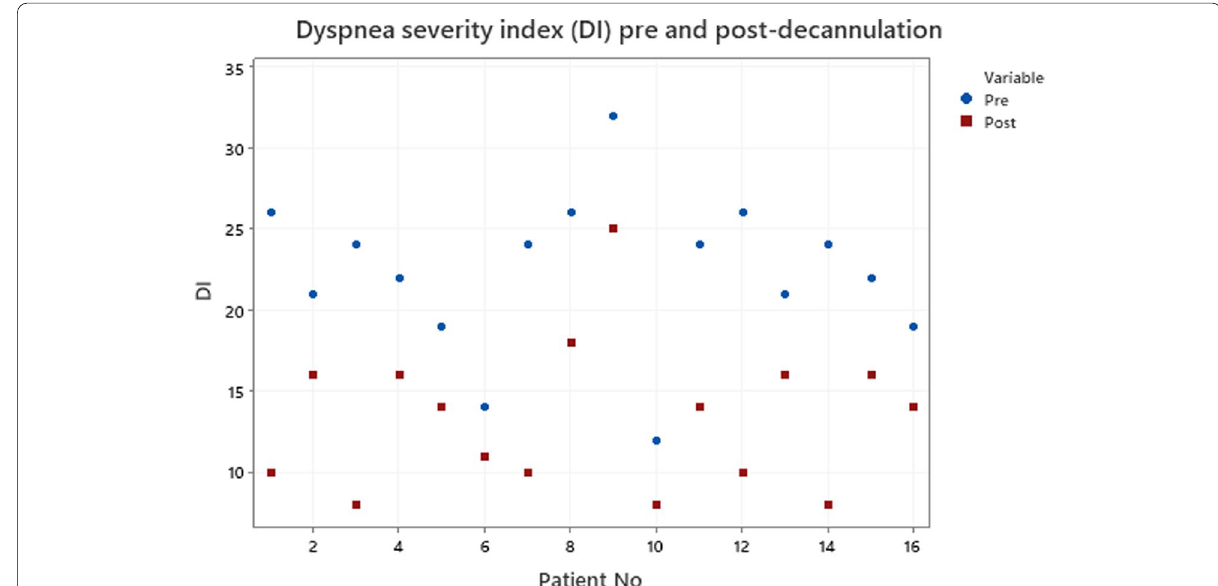
Fig. 1 Plot distribution of dyspnea severity index in all studied subjects before and after decannulation